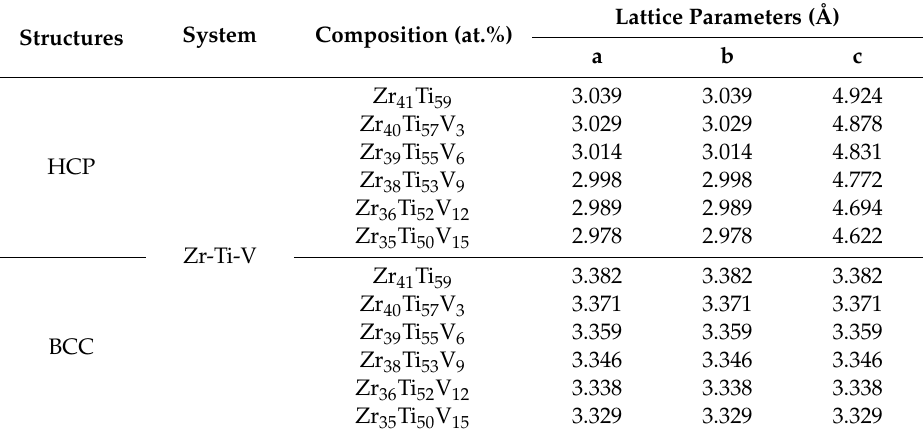
Table 6. E ff ect of V atomic fraction on single crystal cell parameters of HCP structure and BCC structure Zr-Ti-V alloy systems.